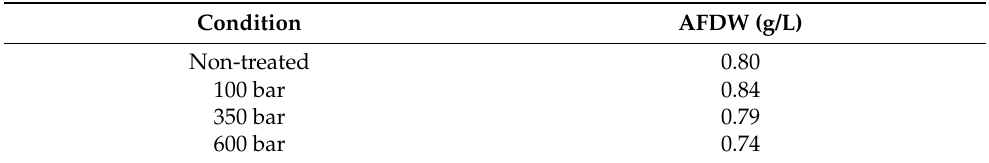
Table 2. Tetradesmus obliquus concentration in ash-free dry weight (AFDW) of the different treatments tested for wheat